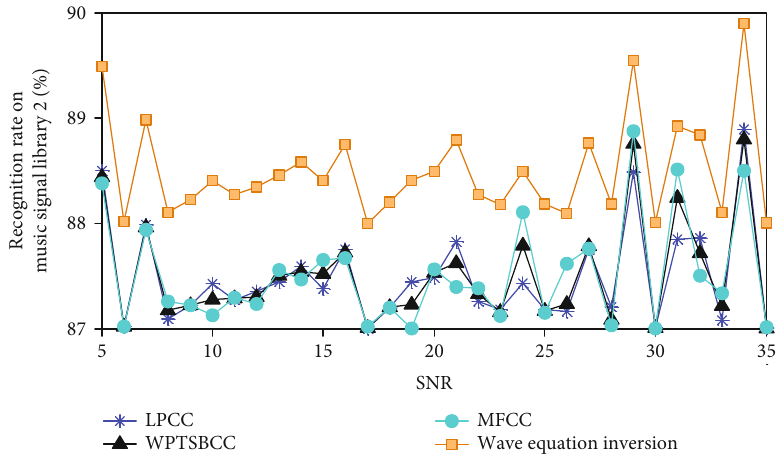
Figure 7: The recognition rate of di ff erent SNR on music signal library